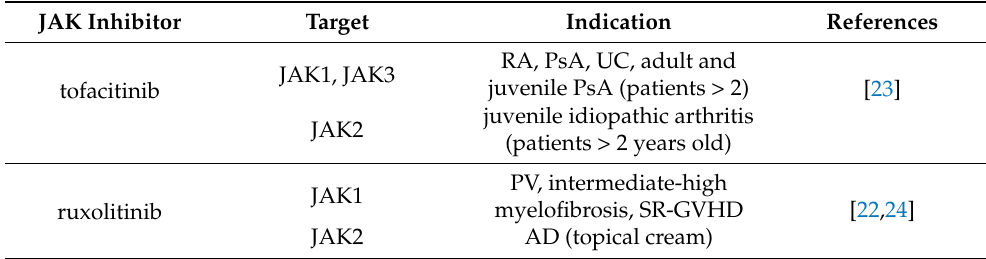
Table 1. Summary of currently approved jakinibs, including JAK selectivity and